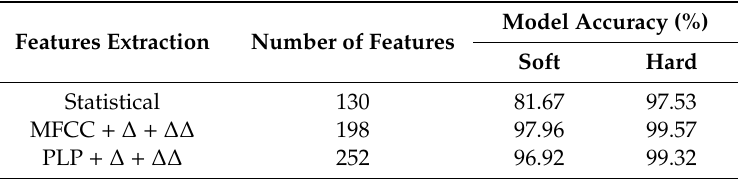
Table 5. Results from di ff erent suspension